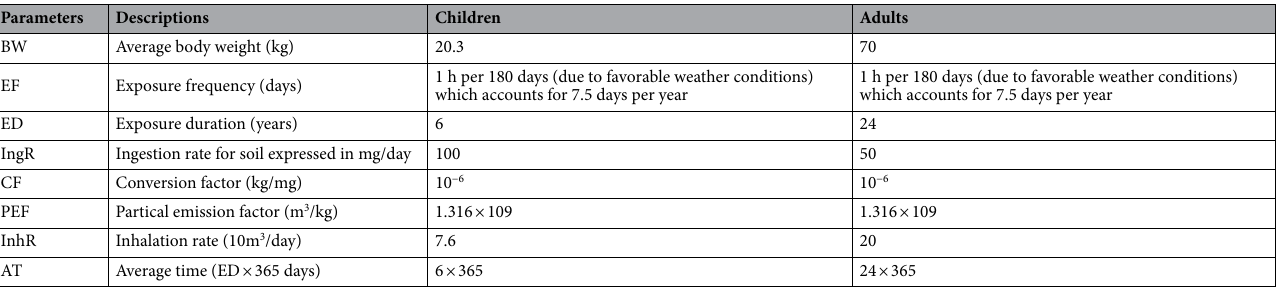
Table 2. Parameters used to assess human health risk 40,46–51